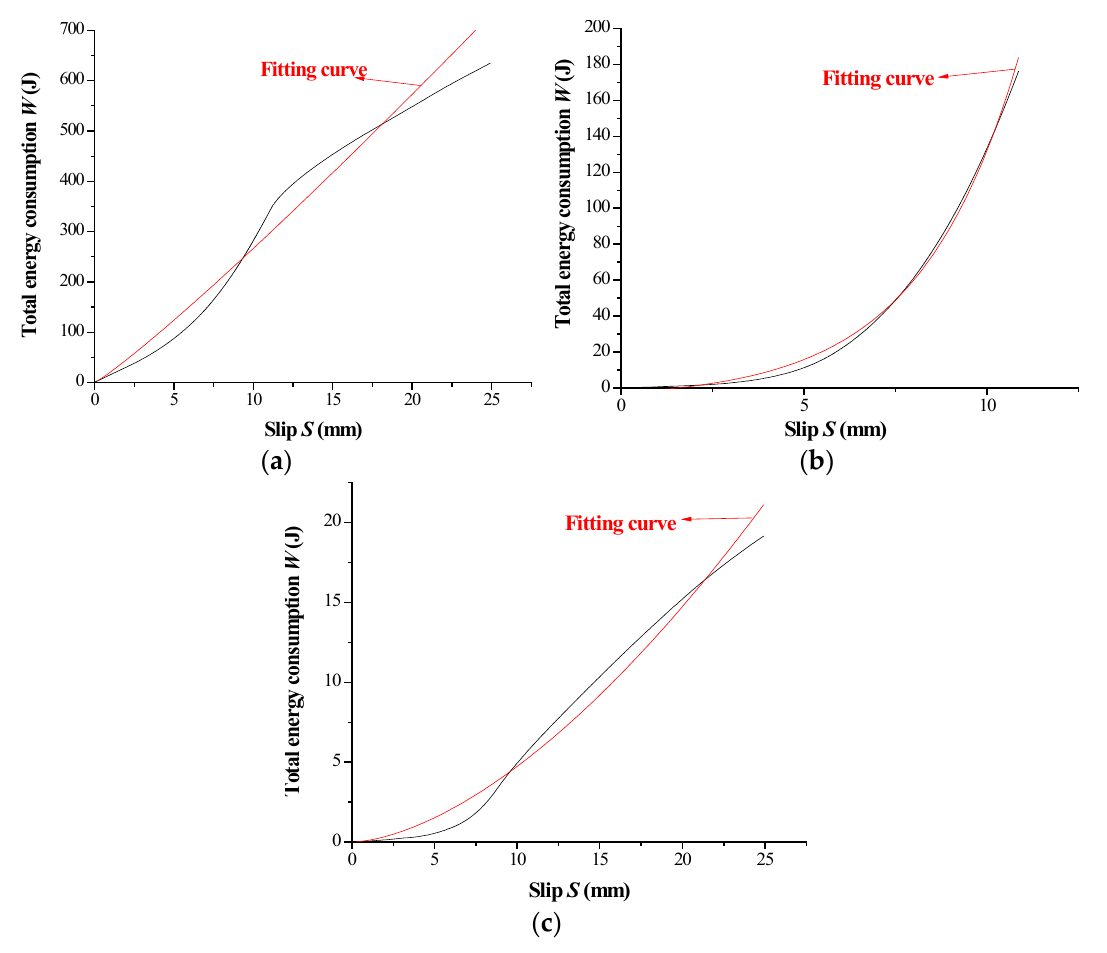
Figure 8. The fitting and test curves of W – S when S 0 is 25 mm and d is 16 mm. ( a ) LWCSB-1-CRB-100; ( b ) LWCSB-3-CRB-100; ( c ) LWCSB-2-PSB-50.